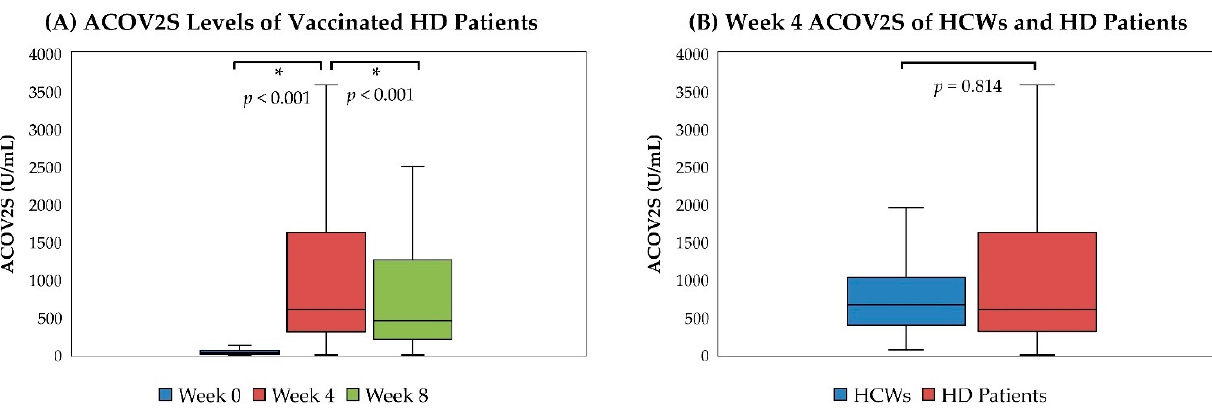
Figure 2. Humoral Responses of HD patients and HCWs after Second Dose of ChAdOx1 nCoV-19 Vaccine. ( A ) ACOV2S levels before and after second dose of vaccination in HD patients ( n = 385); ( B ) comparison of week 4 ACOV2S levels between HCWs ( n = 66) and HD patients ( n = 385). *: p < 0.05.